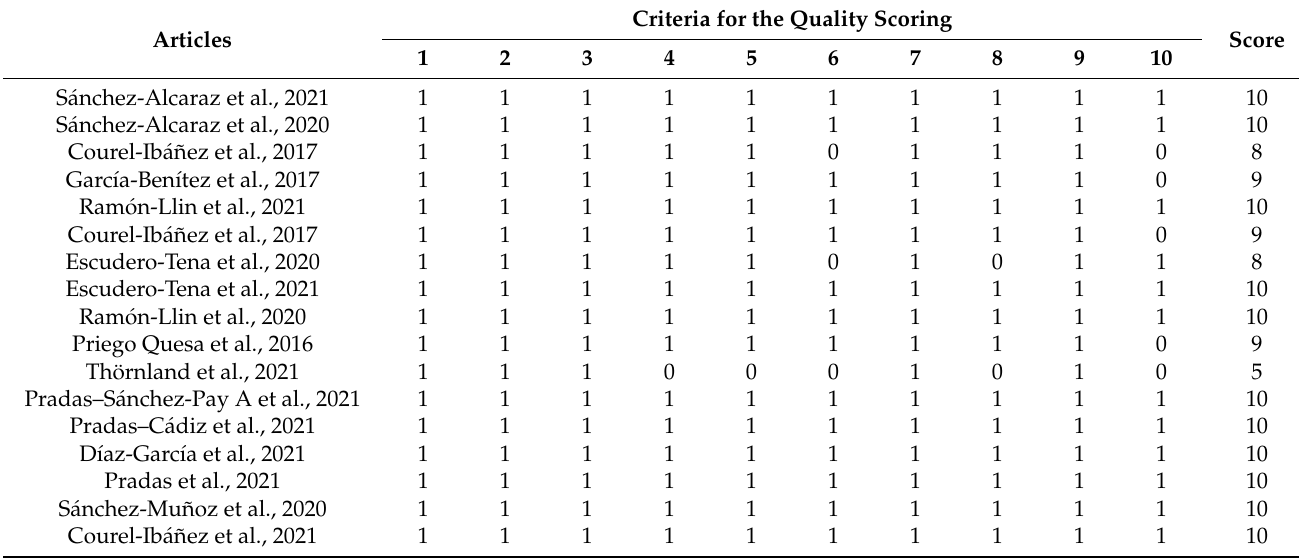
Table 2. Methodological assessment of the included